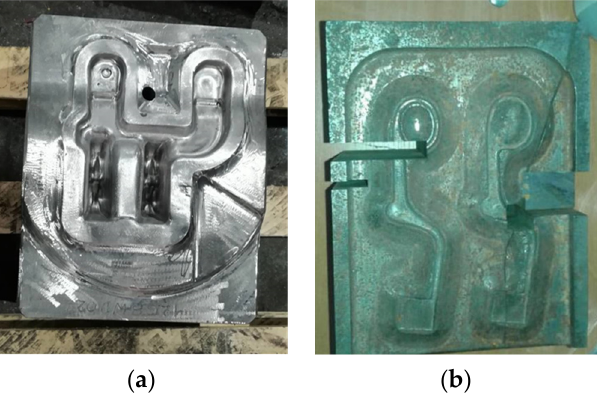
Figure 1. The investigated hot forging tools: ( a ) insert for forging “fork-type” forgings, ( b ) forging die designed for forging wound spreader components. Table 1. The chemical composition of the investigated tool steels. Chemical Composition, wt. %